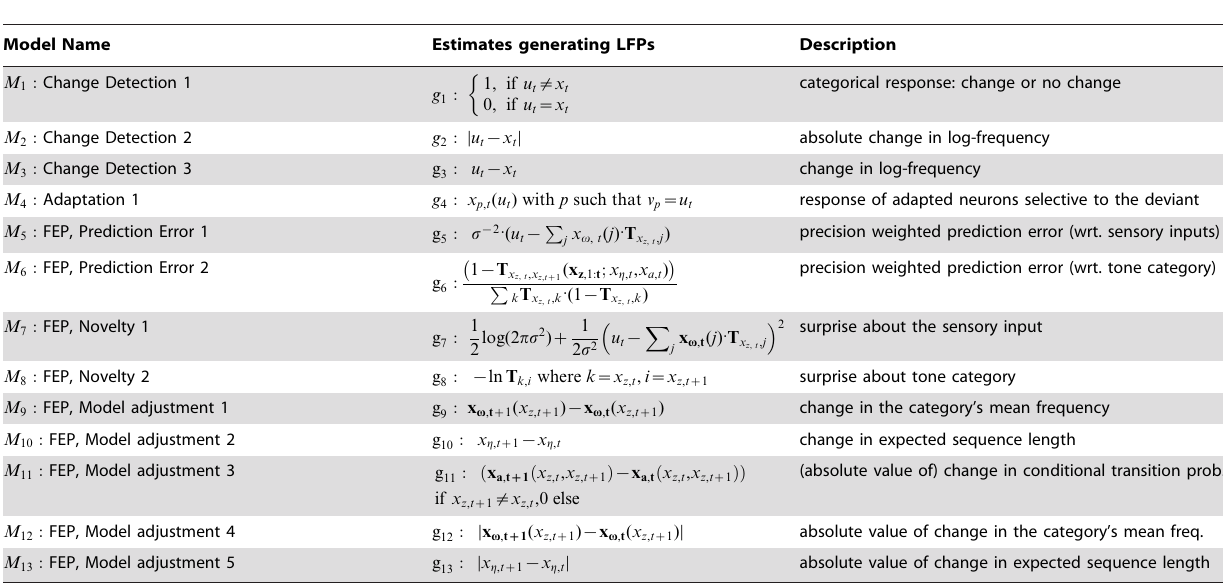
Table 1. This table lists the response models of our 13 computational models of trial-wise MMN amplitudes.